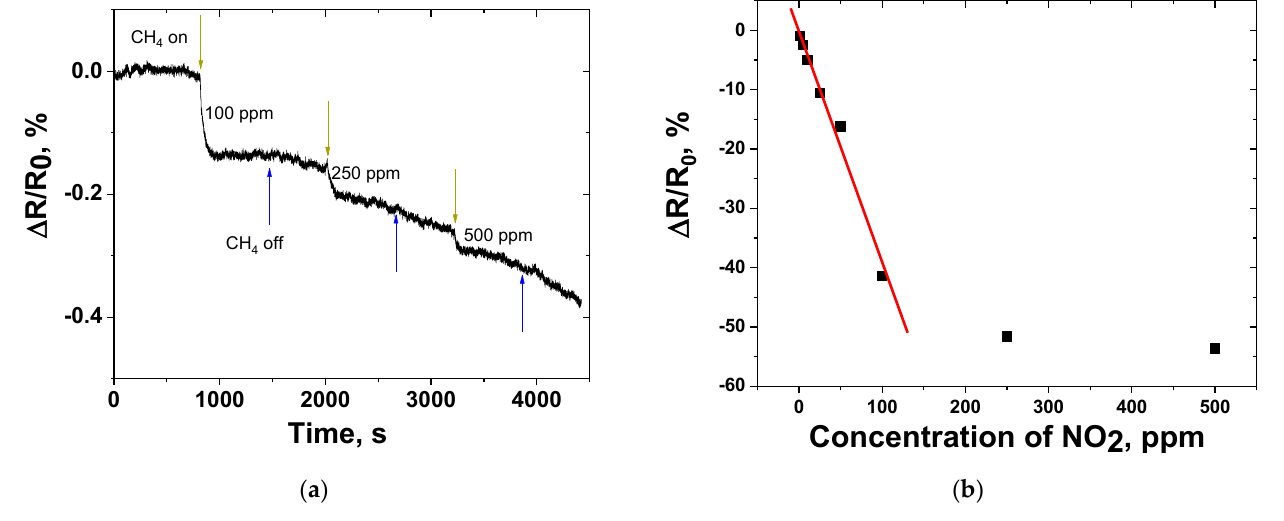
Figure 6. ( a ) Response of CNF-based gas sensor to CH 4 at room temperature (25 ± 2 ° С , air); ( b ) Response vs. concentration of NO 2 at room temperature. The linear fitting line ( Δ R/R 0 = –0.39654 × C NO2 − 0.12341) is marked with red color.